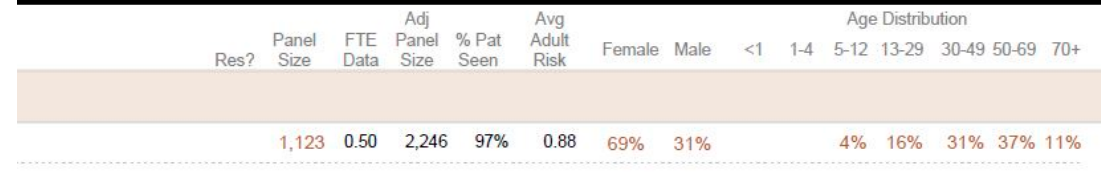
Figure 3. My PCP panel complexity indicators. FTE = full-time equivalence.